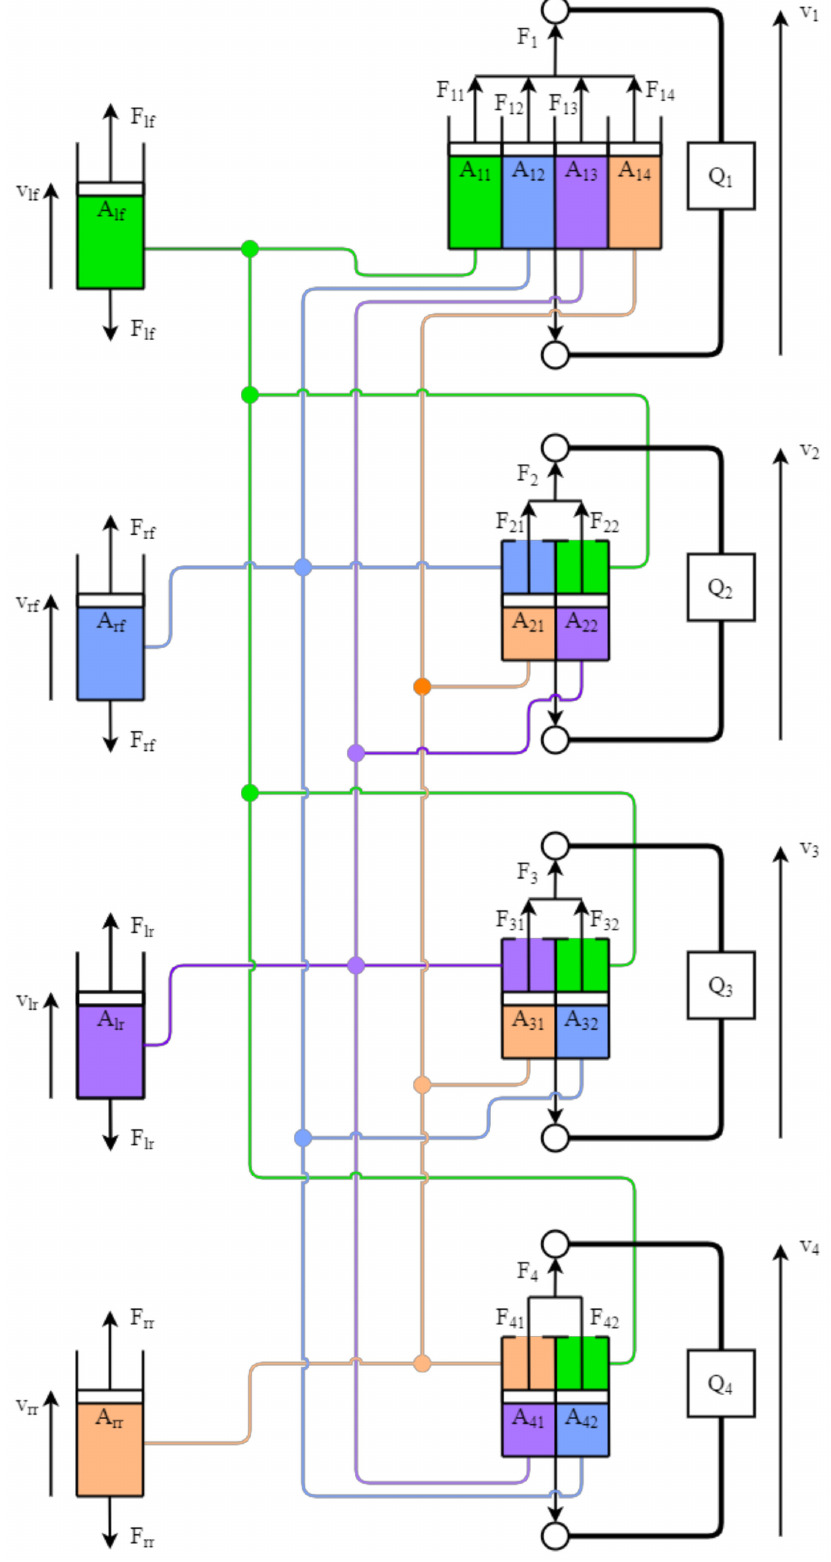
Figure 2. Hydraulically interconnected suspension system proposed by Smith and Walker (repro- duced from [2]) A—area of piston, F—force at the piston, v—piston velocity, and Q—suspension unit admittance (defined by Equation